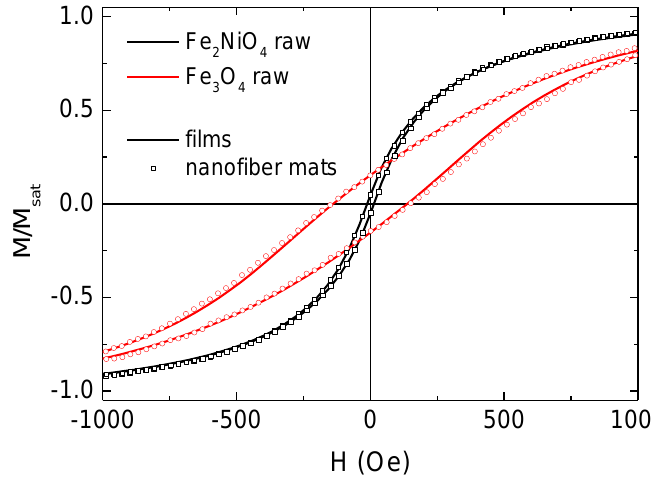
Figure 8. Hysteresis loops of as-prepared nanofiber mats and films from PAN with magnetite or nickel-ferrite nanoparticles, respectively.